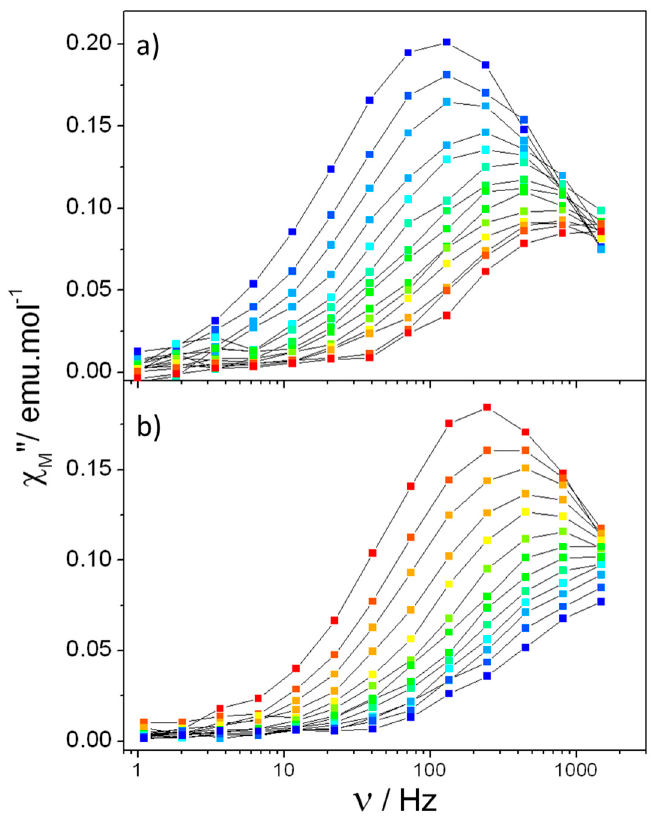
Figure 5. Frequency dependence of the out-of-phase susceptibility of NdMurex ( a ) and NdMurexAnhy ( b ) with H dc = 1200 Oe for temperatures from 1.8 (blue) to 4.4 K (red). Lines are guide to the eye.